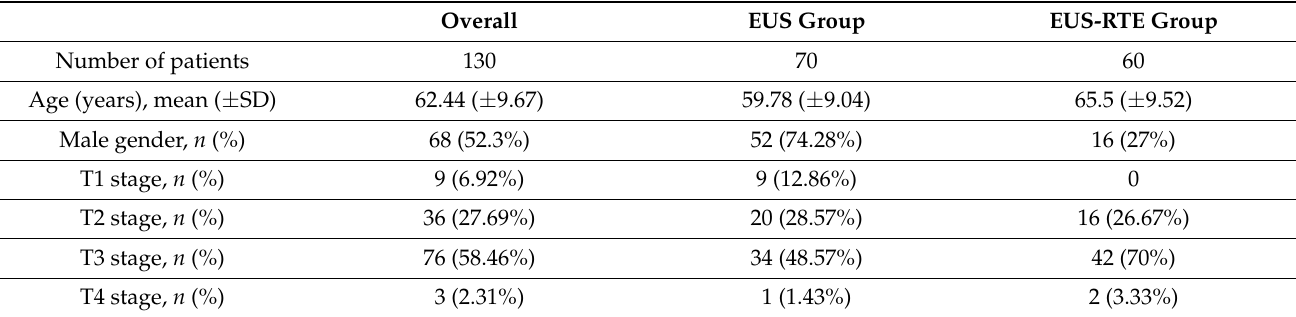
Table 1. Patients’